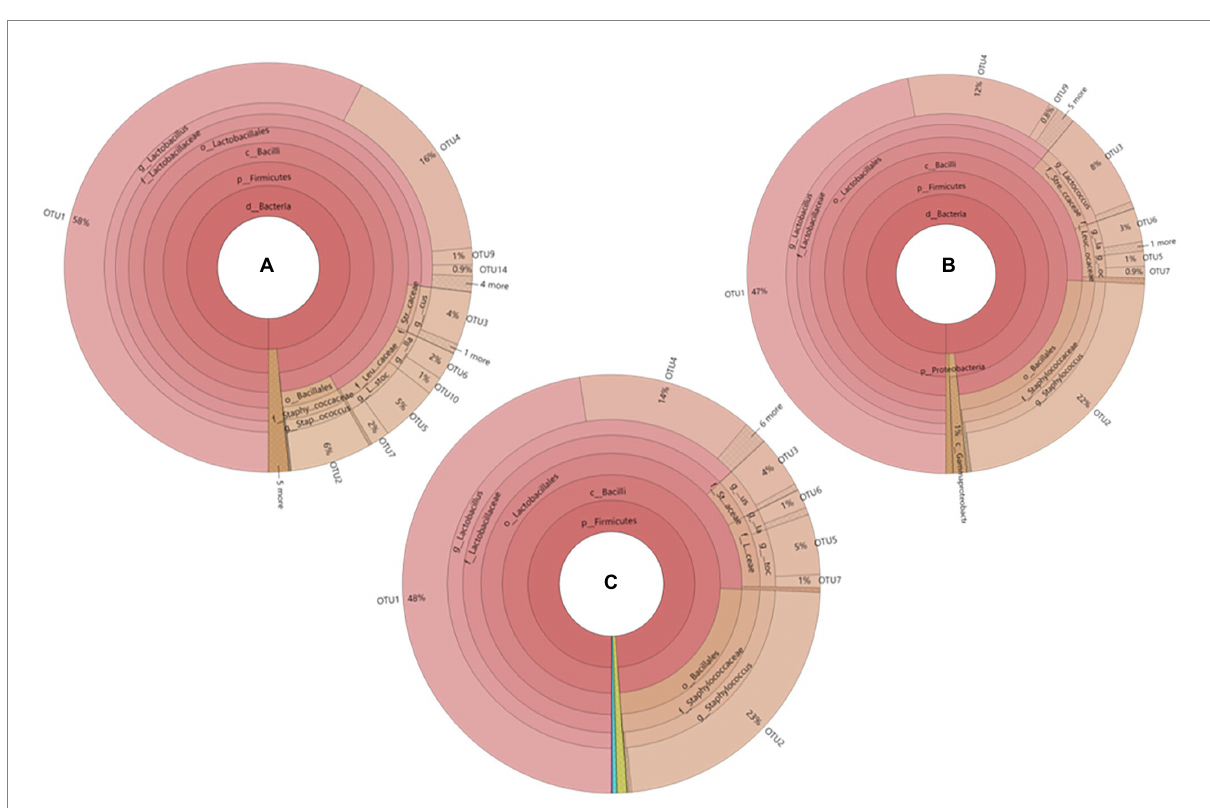
FIGURE 1 Phylogenetic tree of core OTUs in fermented sausage at different ripening stages (A) YM-0d, (B) YM-6d, (C) YM-